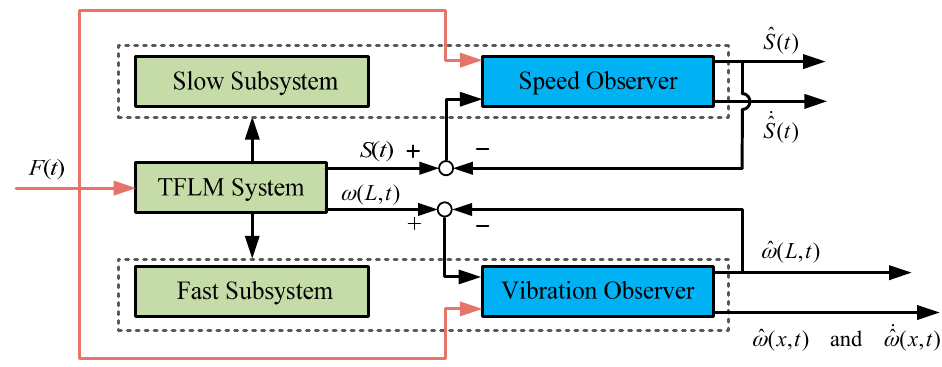
Figure 2. Structure diagram of the two-time scale virtual sensor.